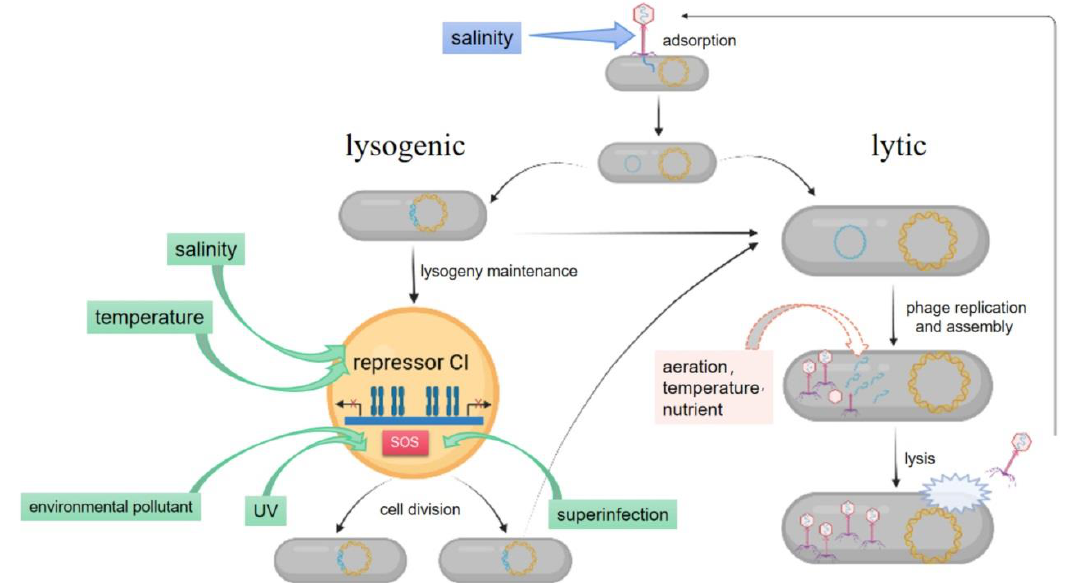
Figure 1. The potential effects of various factors on temperate phage life cycle transition. In the initials of infection, the phage adsorbs to the host cell surface through interacting with host receptors and then injects its genome into the host. Thereafter, the temperate phage enters either the lytic production process or forms a stable coexistence with the host in the lysogenic cycle that is maintained by the repressor protein. Colored arrows indicate factors affecting phage life cycle transition and their potential targets of action. The green solid arrows indicate factors that possibly act on the repressor either directly or indirectly through activation of the host ’s SOS response. The pink dashed arrows indicate factors, which are suggested to affect the physiological state of the hosts and thus influence phage life cycle transition, although their effects and underlying mechanisms remain largely unknown. The dark blue solid arrows indicate that salinity may influence the phage life cycle by affecting the phage ’s adsorption and genome injection.